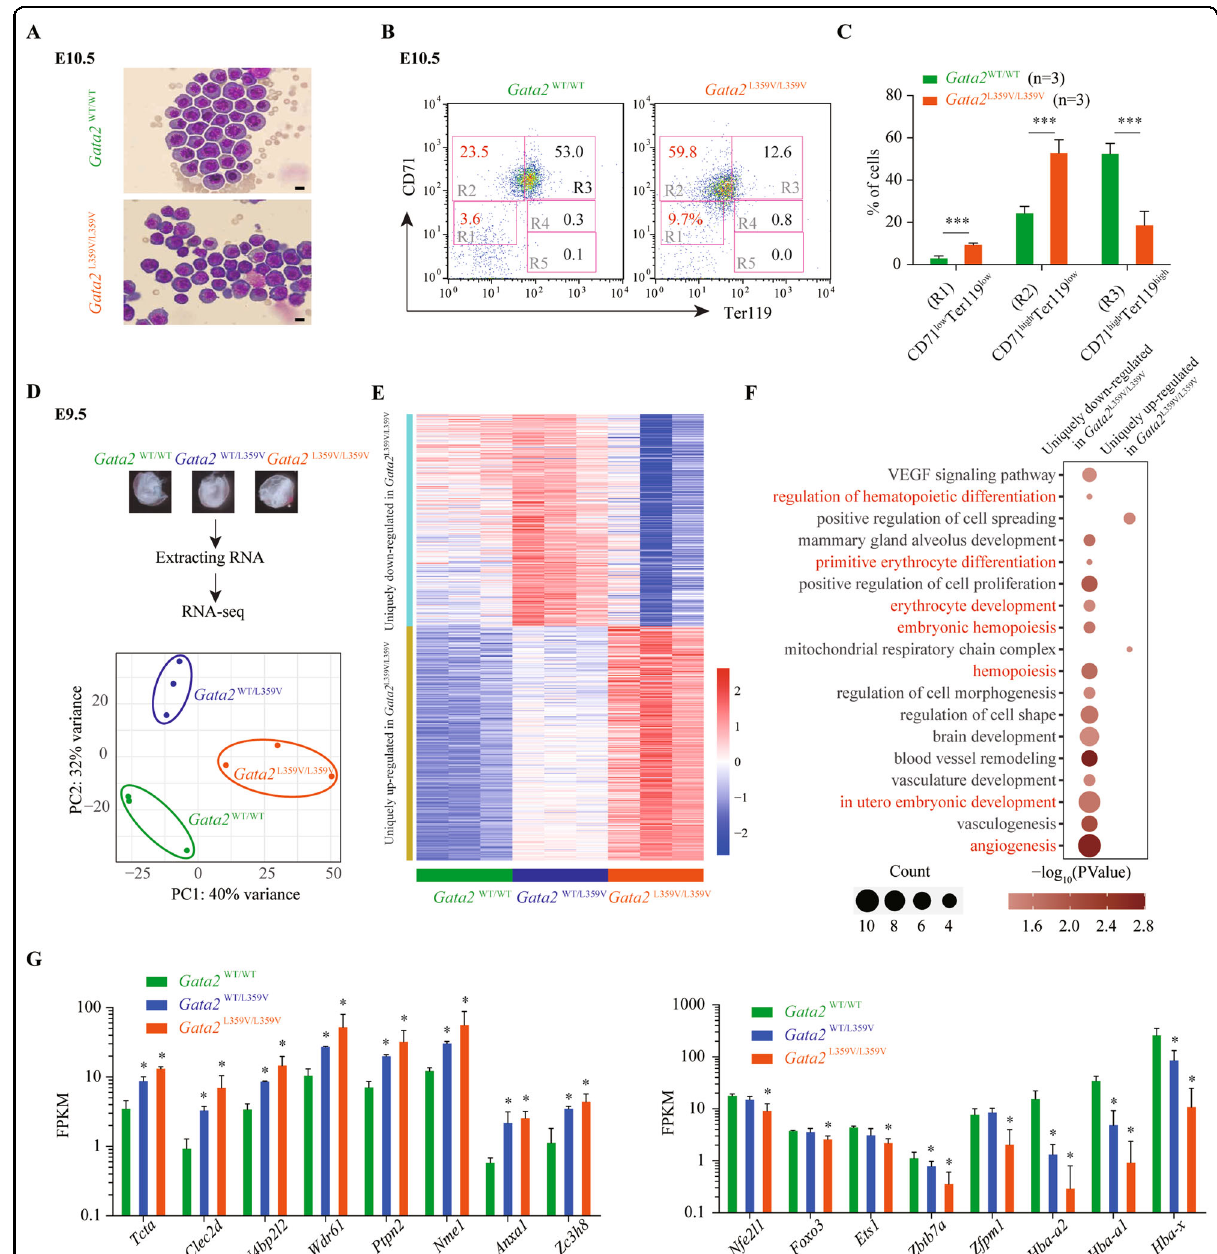
Fig. 2 Erythropoiesis defects in Gata2 L359V/L359V embryos. A Morphological analysis of Gata2 WT/WT (upper panel) and Gata2 L359V/L359V (lower panel) yolk sac erythrocytes by using Wright ’ s staining (scale bar 10 μ m). B Immunophenotype of E10.5 yolk sac cells marked by CD71/Ter119 and the cells were divided into fi ve stages (R1-R5) following the expression levels of CD71 and Ter119. C Statistical analysis of the percentage of CD71 low Ter119 low , CD71 high Ter119 low , and CD71 high Ter119 high cells between Gata2 WT/WT ( n = 3) and Gata2 L359V/L359V ( n = 3). D Principal component analysis (PCA) of the RNA-seq data of the Gata2 WT/WT , Gata2 WT/L359V , and Gata2 L359V/L359V yolk sacs at E9.5. E Heatmap showing a group of genes uniquely down-regulated or upregulated in Gata2 L359V/L359V as compared to Gata2 WT/L359V and Gata2 WT/WT E9.5 yolk sacs. F Gene ontology(GO) analysis of embryonic development genes that were uniquely up/down-regulated in Gata2 L359V/L359V as compared to Gata2 WT/L359V and Gata2 WT/WT E9.5 yolk sacs. G The fragments per kilobase million (FPKM) value of representative genes upregulated or down-regulated in Gata2 L359V/L359V E9.5 yolk sacs ( n = 3, respectively). Error bars represent the standard deviation from the average. Signi fi cant differences are indicated by * p < 0.01 (Student ’ s t